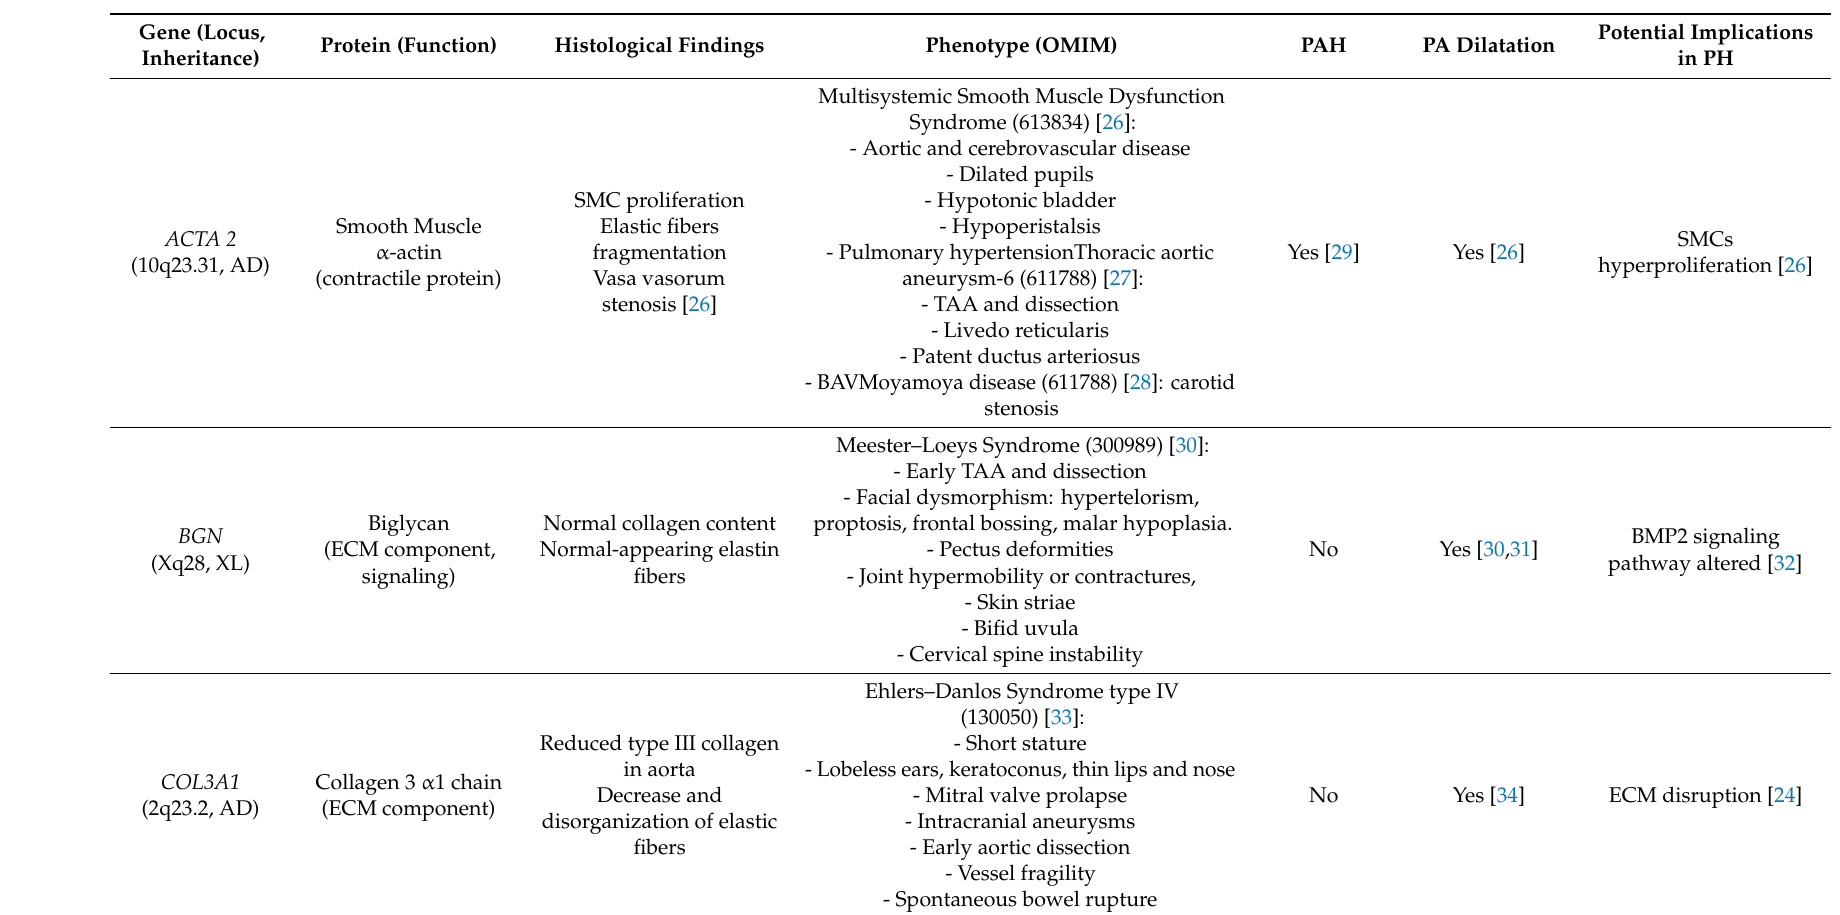
Table 1. Common molecular pathways between thoracic aneurysm and pulmonary hypertension or pulmonary aneurysm. BAV = bicuspid aortic valve; BMP = bone morphogenetic protein; ECM = extracellular matrix; OMIM = online mendelian inheritance in man; PA = pulmonary artery; PAH = pulmonary arterial hypertension; PH = pulmonary hypertension; SMC = smooth muscle cell; TAA = thoracic aortic aneurysm; TGF- β = transforming growth factor β ** PH and PA dilatation in Adams–Oliver syndrome related to pulmonary vein stenosis. ˆˆ Loss of SMAD3 function promotes vascular remodeling but PH has not been described in patients with pulmonary